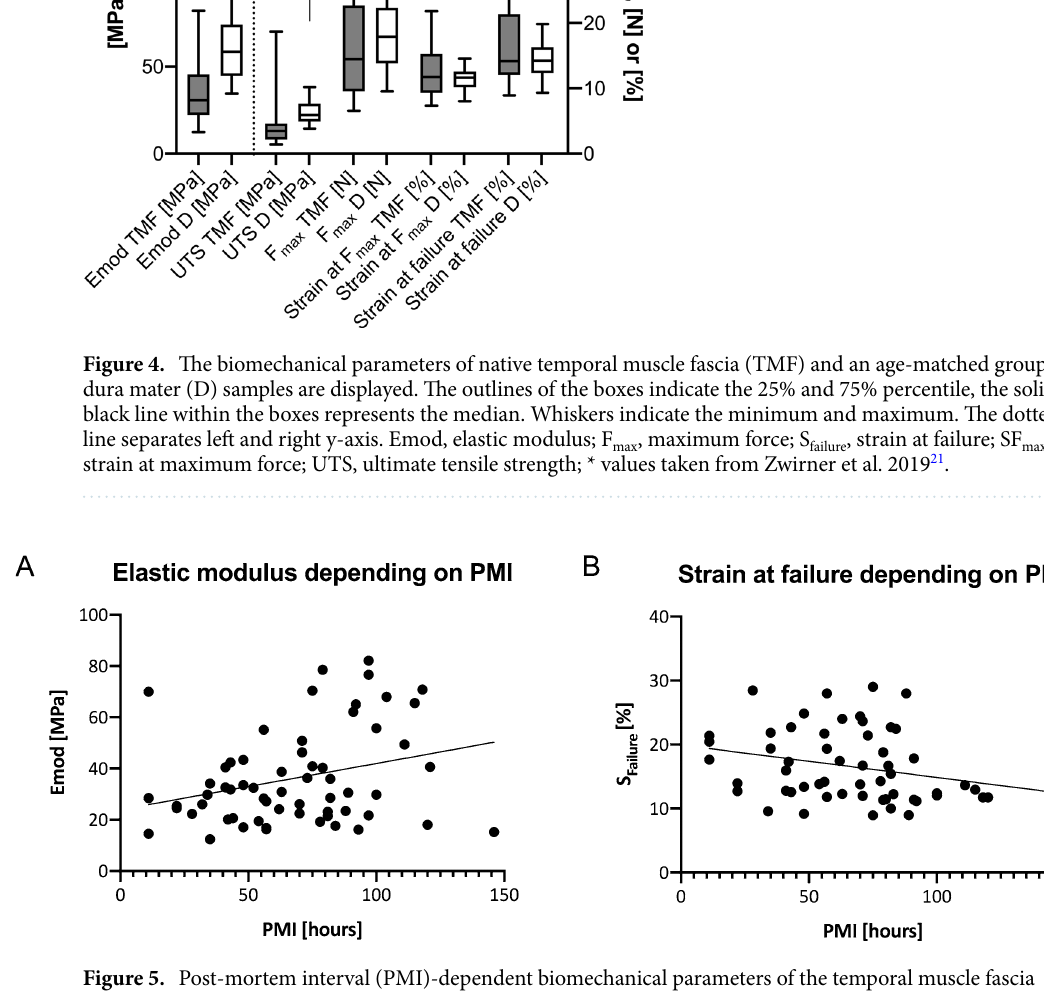
Figure 5. Post-mortem interval (PMI)-dependent biomechanical parameters of the temporal muscle fascia (TMF). ( A ) The elastic modulus of the TMF significantly increases with longer PMIs. ( B ) The strain at failure of the TMF significantly decreases with longer PMIs. Emod, elastic modulus; S failure , strain at force (male: 13 ± 4%, female: 13 ± 6%; p = 0.848) nor strain at failure (male: 16 ± 5%, female: 18 ± 6%; p = 0.557). Moreover, there was no statistically significant difference regarding male (73 ± 30 h) and female (67 ± 25 h) PMI ( p = 0.076). The biomechanical TMF parameters are separately displayed for males and females in Fig. 7. H&E staining of TMF.